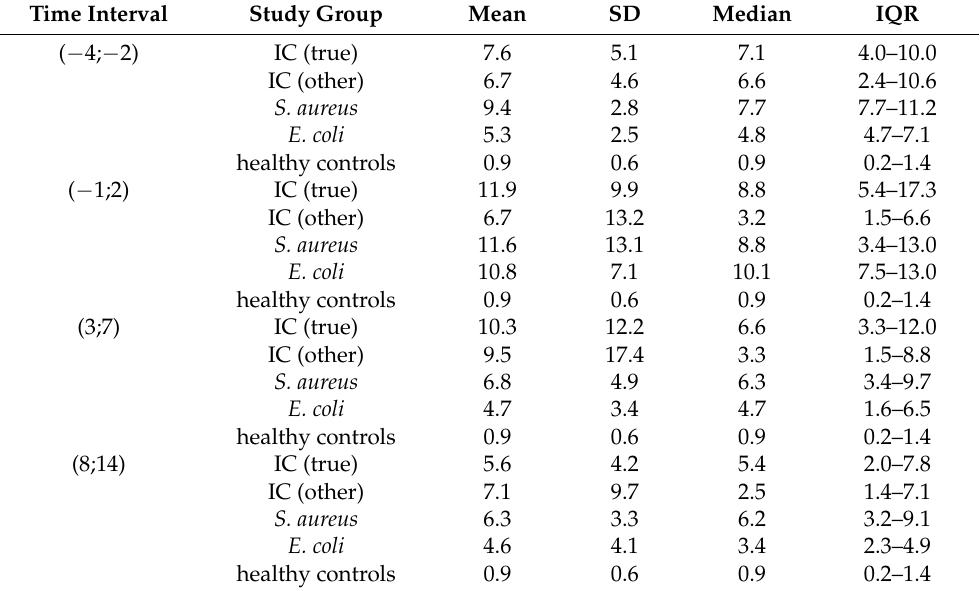
Table A3. Descriptive statistics of interleukin 17A